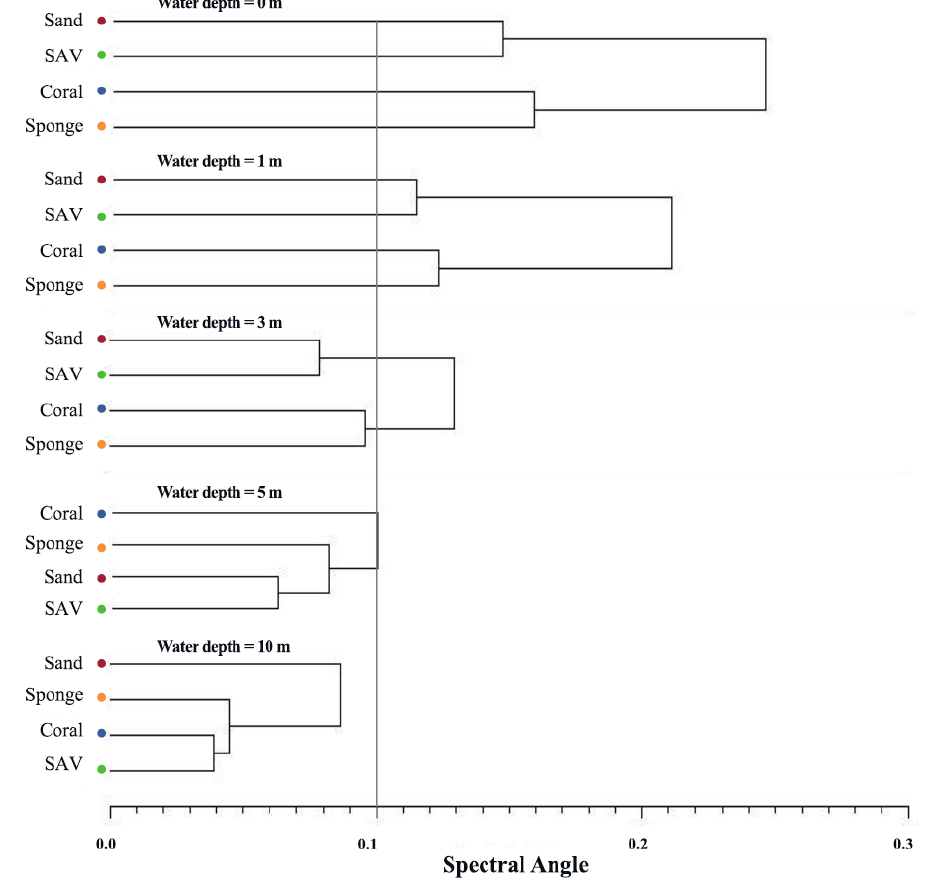
Figure 5. Optical dendrograms illustrating the effect of increasing depth on separability of field spectra grouped into four fundamental reef components: coral, sponge, submerged aquatic vegetation (SAV), and